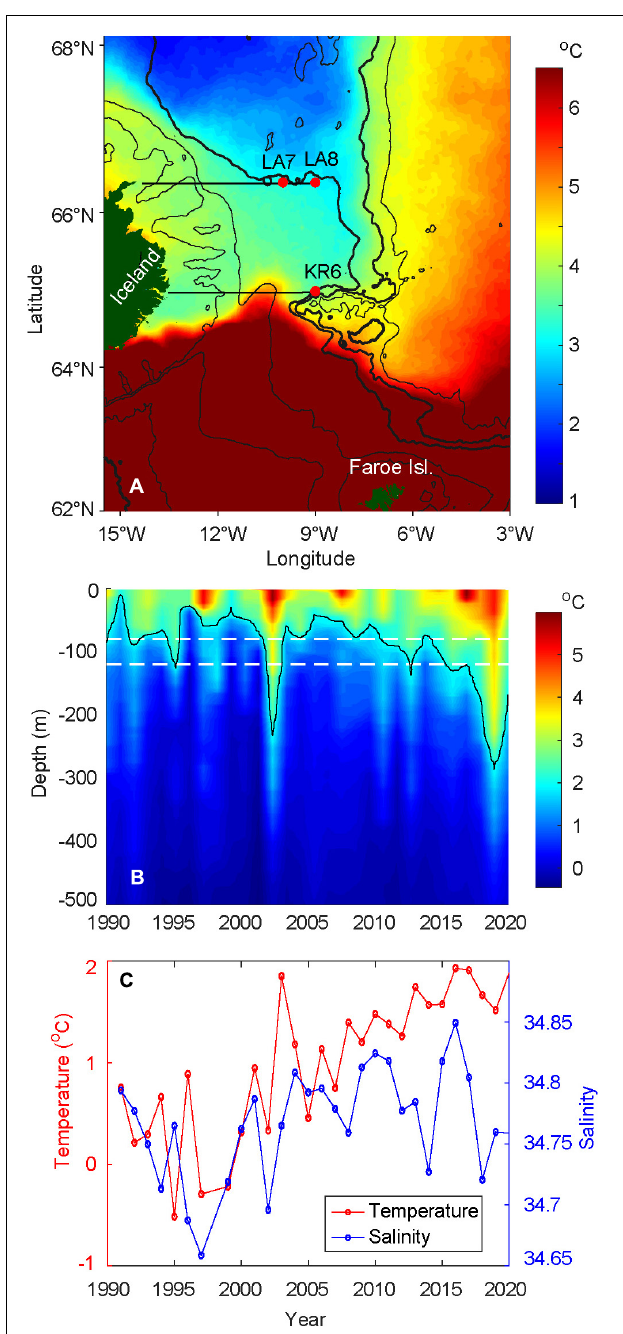
FIGURE 6 | Hydrographic conditions near the feeding spot. (A) Average sea surface temperatures, in May, from 2003–2020, (B) depth-time plot of temperature, at KR6 from 1991 to 2020, and (C) average temperature and salinity conditions in May at LA7 and LA8, from 1991 to 2020, at depth between 80 and 120 m [white dashed lines in (B) ]. See Supplementary Figures 2, 3 for detailed hydrographic conditions for the selected Icelandic sections. In (C) , data is not available in 1998. The red dots in (A) are the positions of the selected Icelandic sections. The 200, 500, 1,400 (bold), 2,000 (bold), and 2,500 m isobaths are shown in black. In (B) , the 2 ◦ C isothermal limit is displayed in